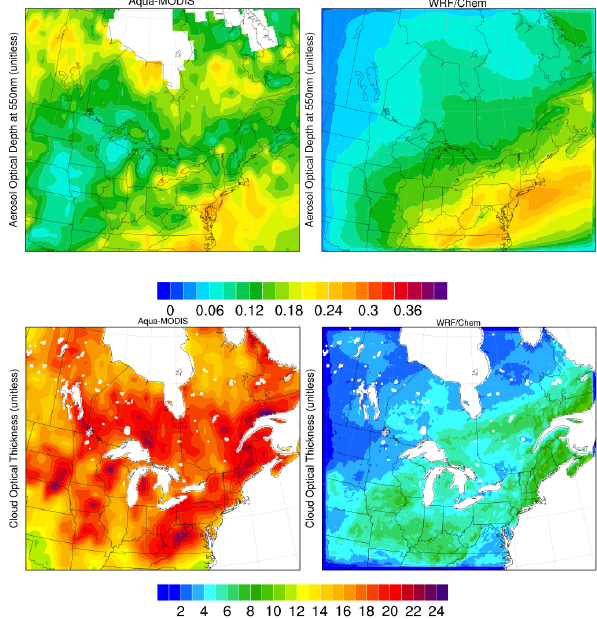
Figure 3. Comparison of MODIS-Aqua products and WRF/Chem three-month average (JJA) total column Aerosol Optical Depth at 550nm (top) and Cloud Optical Thickness